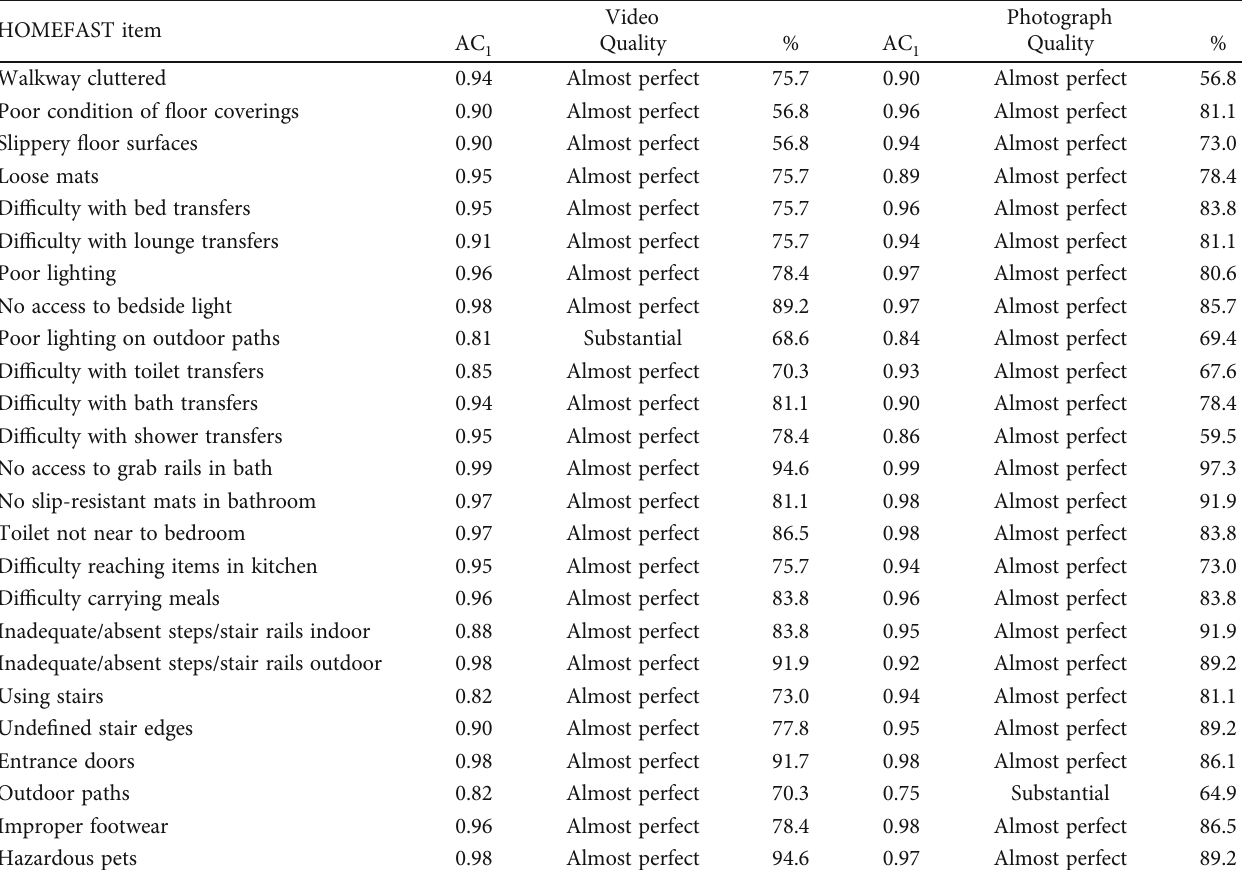
Figure 3: Bland-Altman lot for interrater reliability (photograph). Table 4: Findings on the test-retest reliability of HOME FAST video and